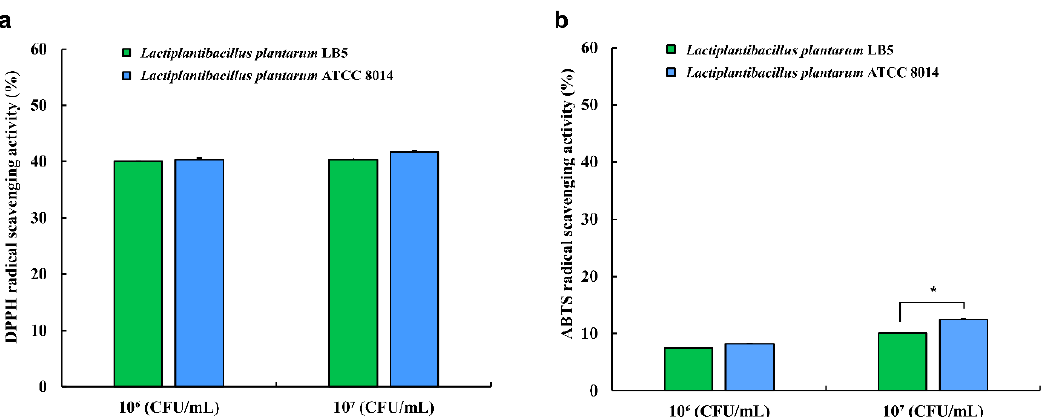
Figure 7. Antioxidant activity of LPLB5 and L. plantarum ATCC 8014. ( a ) 2,2-diphenyl-1-picryl- hydrazyl (DPPH) and ( b ) 2-azino-bis-(3-ethylbenzothiazoline-6-sulfonic acid (ABTS) radical scavenging activities were determined. The results represent the mean ± SEM, with n = 3. * indicates a significant difference vs. control (* p < 0.05).